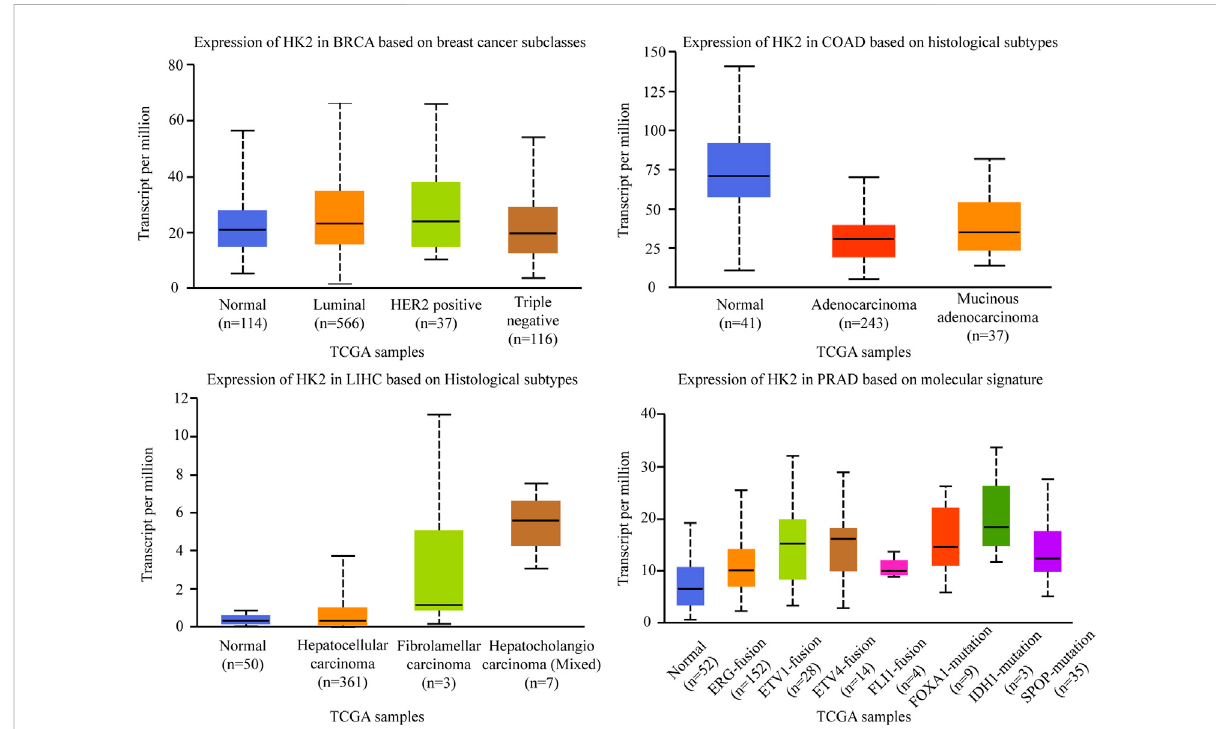
FIGURE 6 Association of HK2 gene expression with histological subtypes and molecular signature in different cancers. BRCA, breast invasive carcinoma. COAD, colon adenocarcinoma. LIHC, liver hepatocellular carcinoma. PRAD, prostate